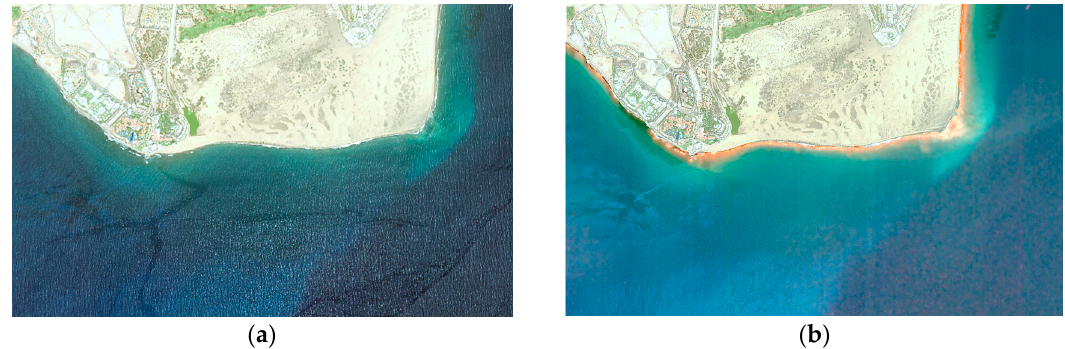
Figure 4. ( a ) WorldView-2 color composite image of Maspalomas (Gran Canaria Island, June 2015) and ( b ) image after sunglint correction using the algorithm implemented in [28].